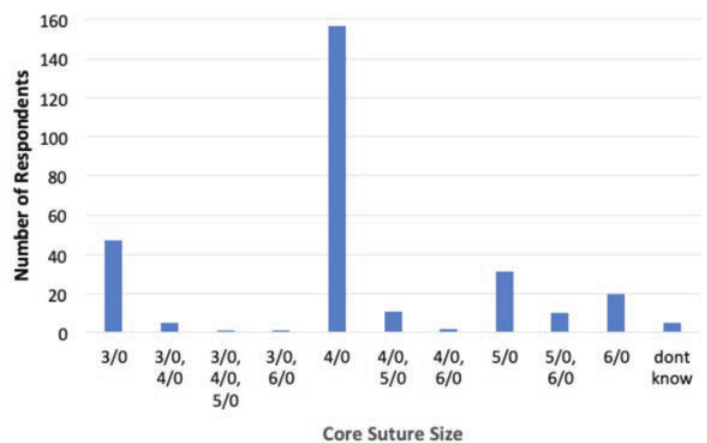
Preferred core suture size of respondents in flexor tendon Fig. 3: